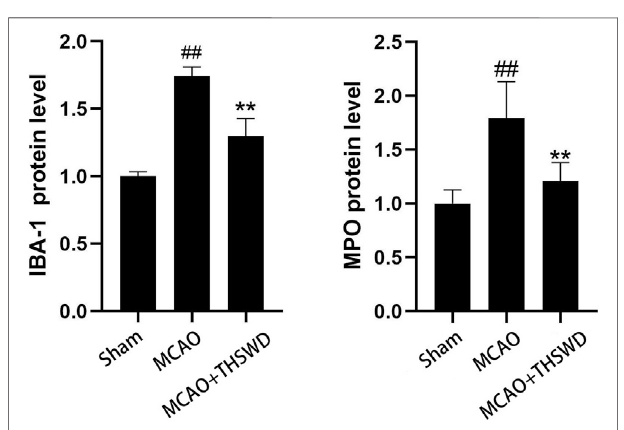
FIGURE 6 | Protein expression of IBA-1 and MPO Notes: ## P < 0.05 vs Sham operation group; ** P < 0.05 vs MCAO group.